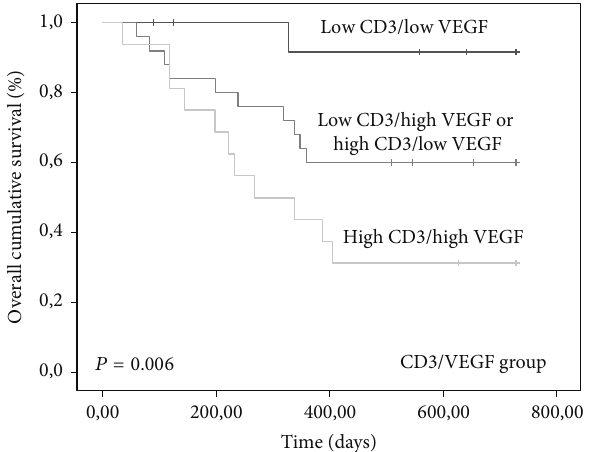
Figure 8: Kaplan-Meier overall survival curves comparing CD3/VEGF group categories in 80 dogs with malignant mammary tumors.